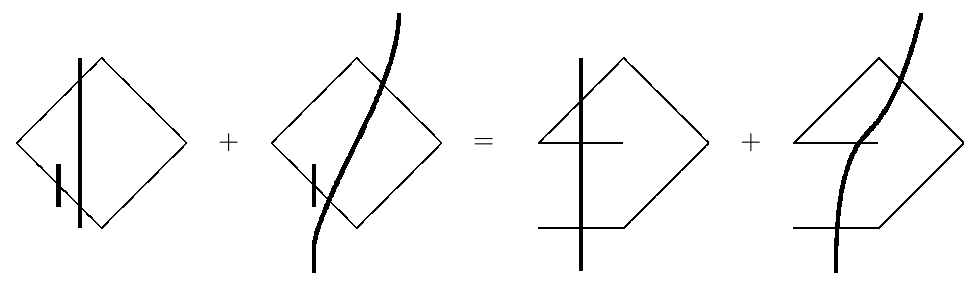
Figure 6 . Contributions to A (1) . The (cid:12)gure on the left hand side expresses it as a sum of cut 1 diagrams of the original graph, with the propagator 1 replaced by the cut propagator. The right hand side shows this as a sum of cuts of a tree diagram in which the propagator 1 is replaced by a pair of incoming and outgoing lines. We have not shown the external states of the original amplitude A in any of the diagrams.